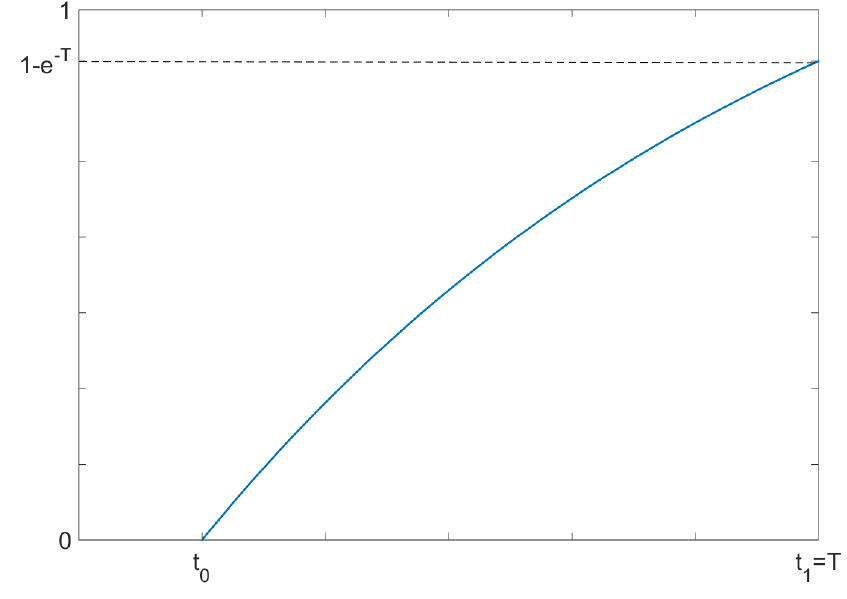
Figure 2. The exponential c.d.f. F ( t ) = 1 − e − ( t − t 0 ) in the interval [ t 0 , t 1 ]